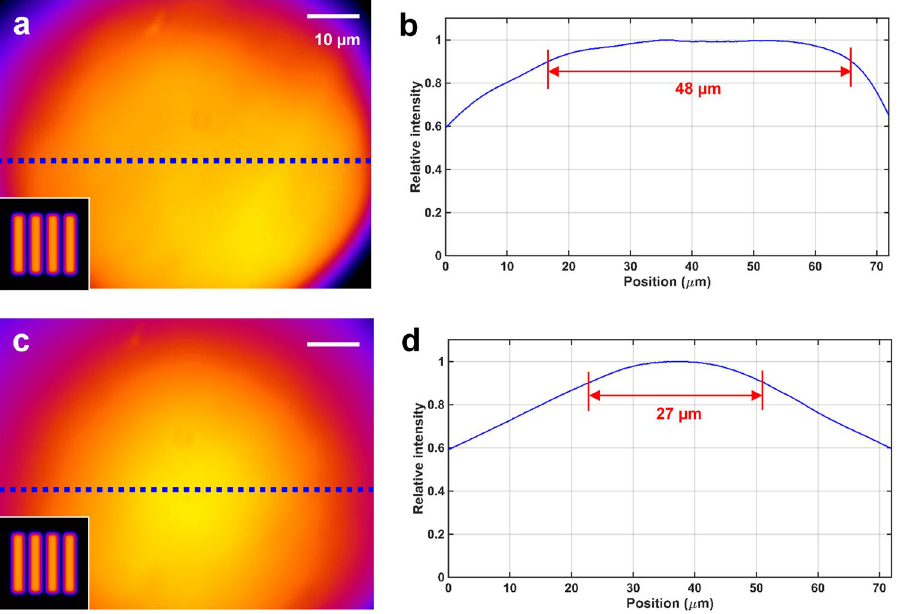
Figure 2. Uniformity of the illumination field in the low-cost SMLM by using different diffusers. ( a , c ) Spatial distribution of illumination intensity generated by the flat-top diffuser. ( b ) The corresponding intensity profile across the blue dotted line in a. The size of the illumination field with a relative intensity larger than 90% is 48 µ m. ( c ) Spatial distribution of illumination intensity generated by the Gaussian diffuser (#47-994, Edmund Optics). ( d ) The corresponding intensity profile across the blue dotted line in ( c ). The size of the illumination field with a relative intensity larger than 90% is 27 µ m. Note that, the inset shown in the left bottom corner in ( a , b ) is the original illumination pattern without